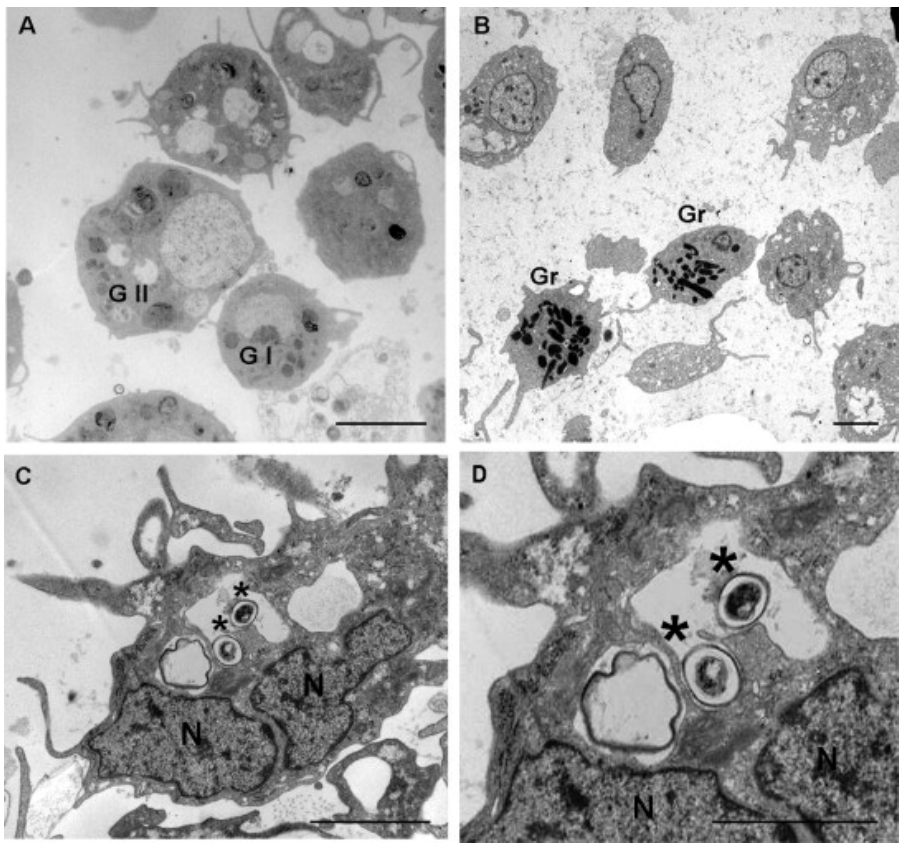
Figure 2. Hemocytes of P. canaliculata (freshwater snail) observed at TEM. ( A ) Group I (G I) and II (G II) agranular cells, both with regular shapes but different dimensions, are observable. ( B ) Group II (Gr) granular hemocytes show electron-dense granules. ( C , D ) Phagocytosis of bacteria (*) is observed in group II cells. N—nucleus [17].